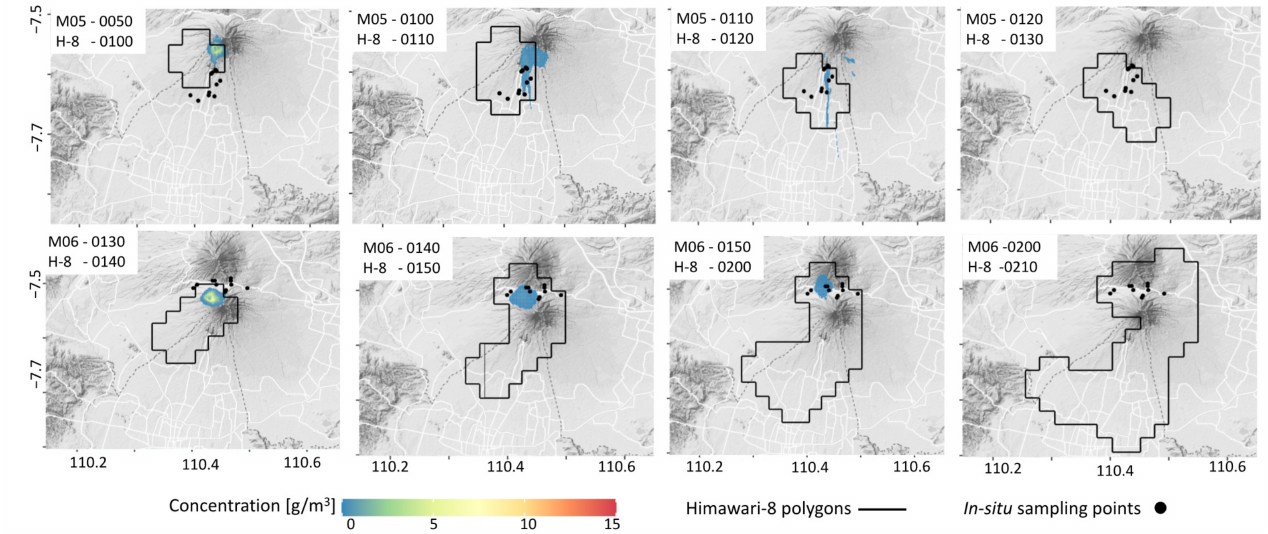
Figure 10. Mean ensemble of tephra concentration and area of detected tephra cloud by Himawari-8 (given by black polygons). The study cases and time stamps are indicated in the top left corner. The detected area of Himawari-8 (cid:48) s tephra cloud was transformed into a polygon using cloud temperature < 285 K. The ground-based data points are also presented in each map, given by black dots. In each image, the x - and y -axis are longitude and latitude,